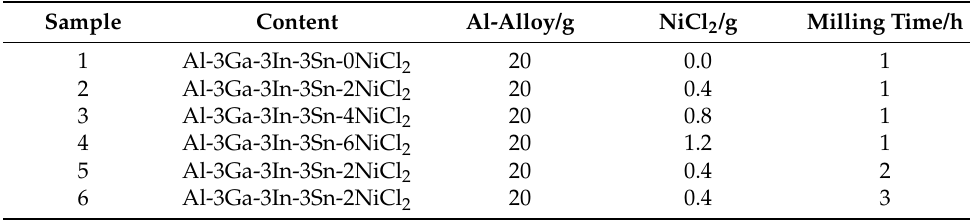
Table 1. Composition of Al-LMP-NiCl 2